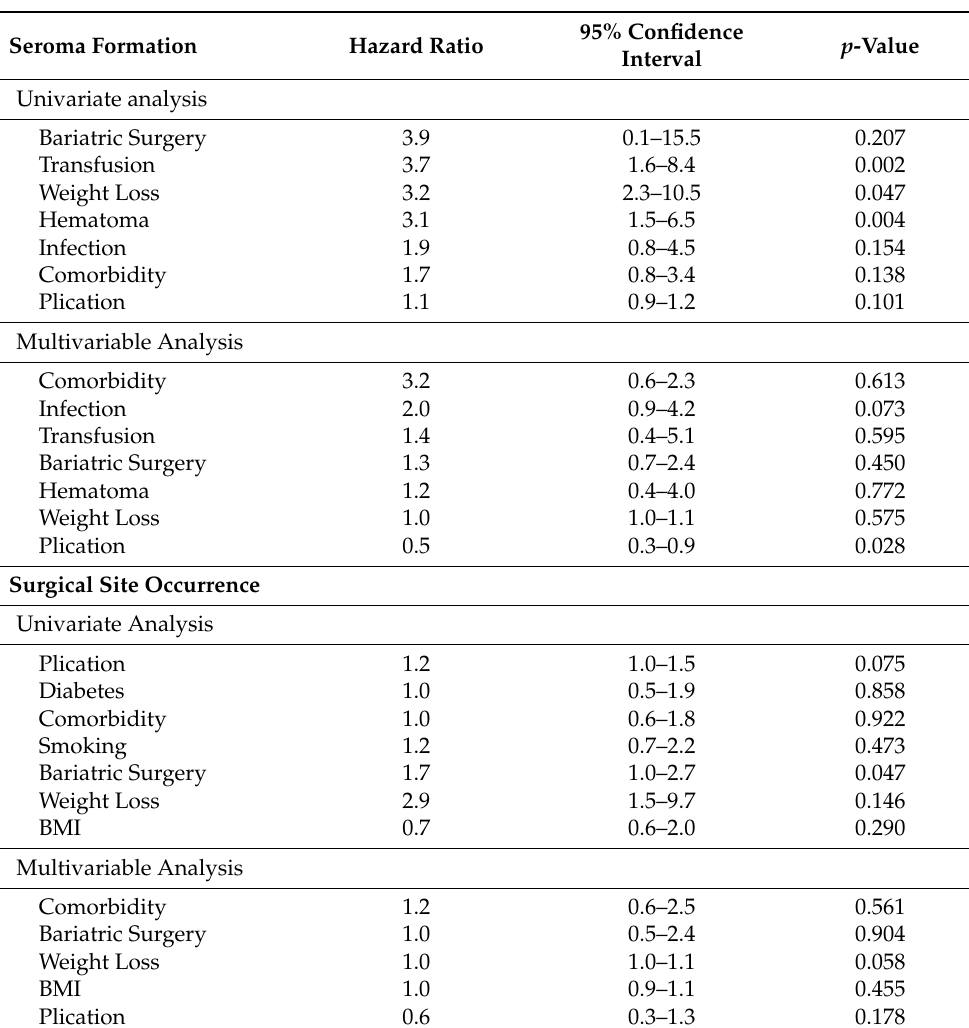
Table 4. Univariate and multivariable analyses of factors related to seroma formation and surgical site occurrence. Abbreviations: BMI, body mass